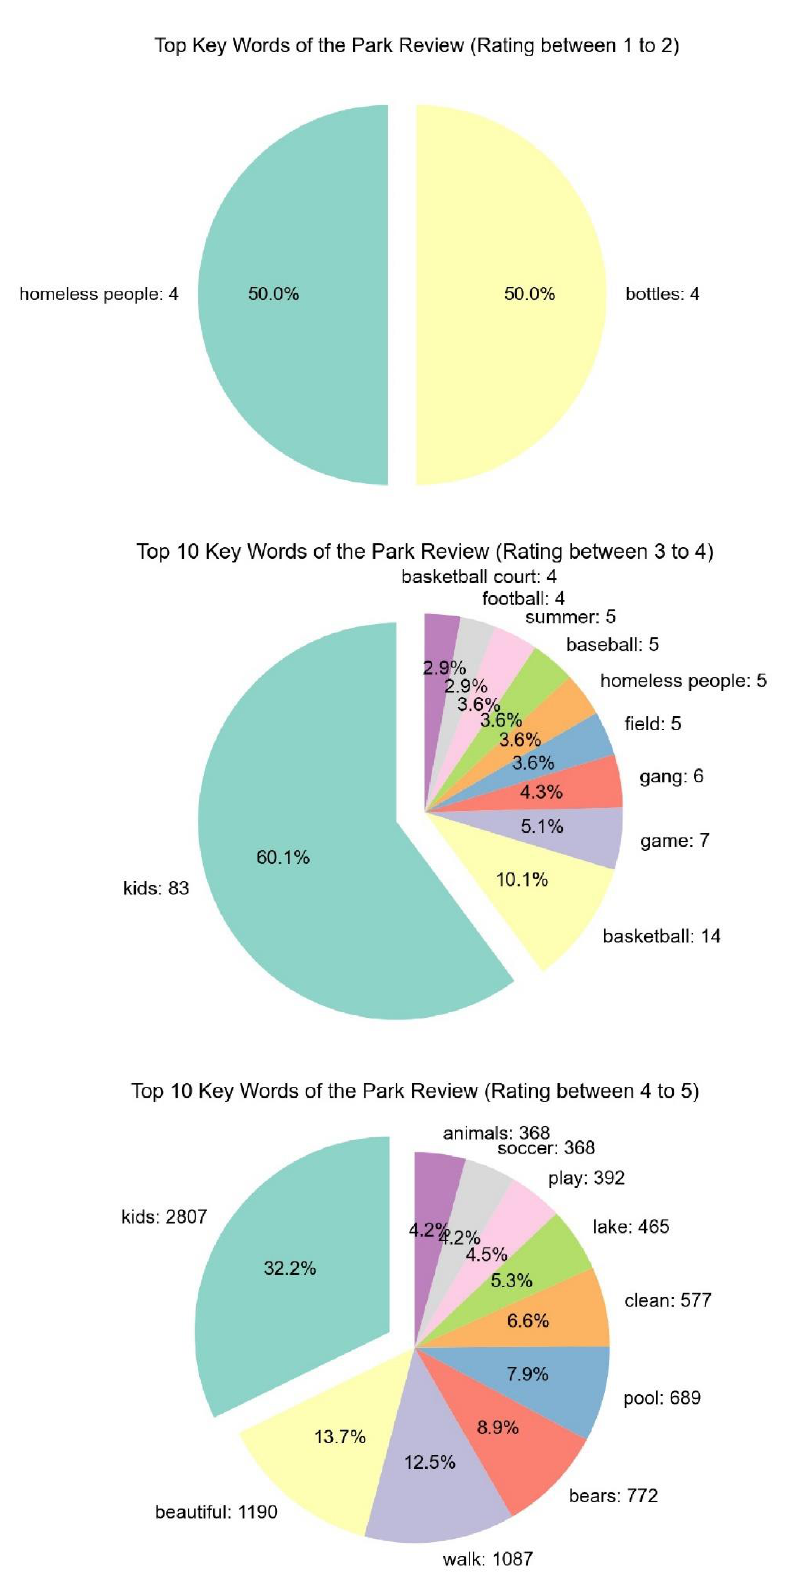
Figure 9. Pie charts of the park review keywords frequency by different ratings. From top to bottom: rating 1 to 2, rating 3 to 4, and rating 4 to 5.